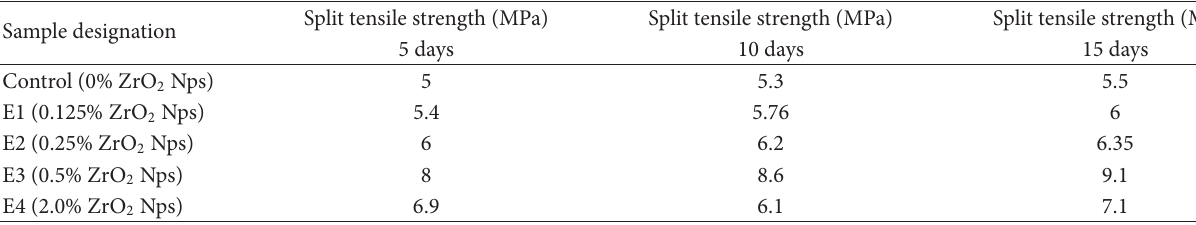
T 3: Split tensile strength of cement modi�ed with ZrO 2 Nps.